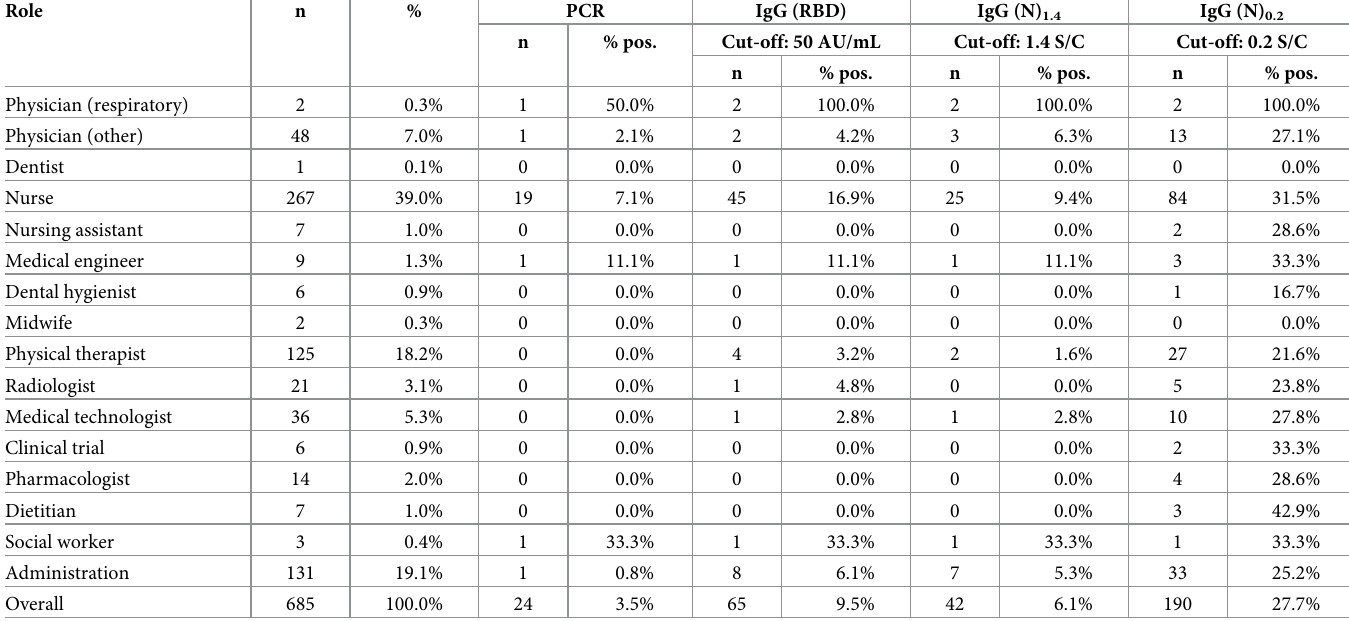
and 27.7%, respectively. In terms of absolute number of positive cases, nurses were at the high- est by all the methods. Positive rates between HCW’s in COVID-19 and non-COVID-19 ward In Table 3, we compared positive rates in HCW’s who worked in COVID-19 ward and those who worked outside of COVID-19 ward by the four methods: PCR, IgG (RBD), IgG (N) and IgG (N) . The positive rates in HCW’s in COVID-19 ward were significantly higher by 0.2 Pearson’s chi-square test with all the methods. Table 2. Positive rates of PCR, IgG (RBD), IgG (N) 1.4 , and IgG (N) 0.2 by job